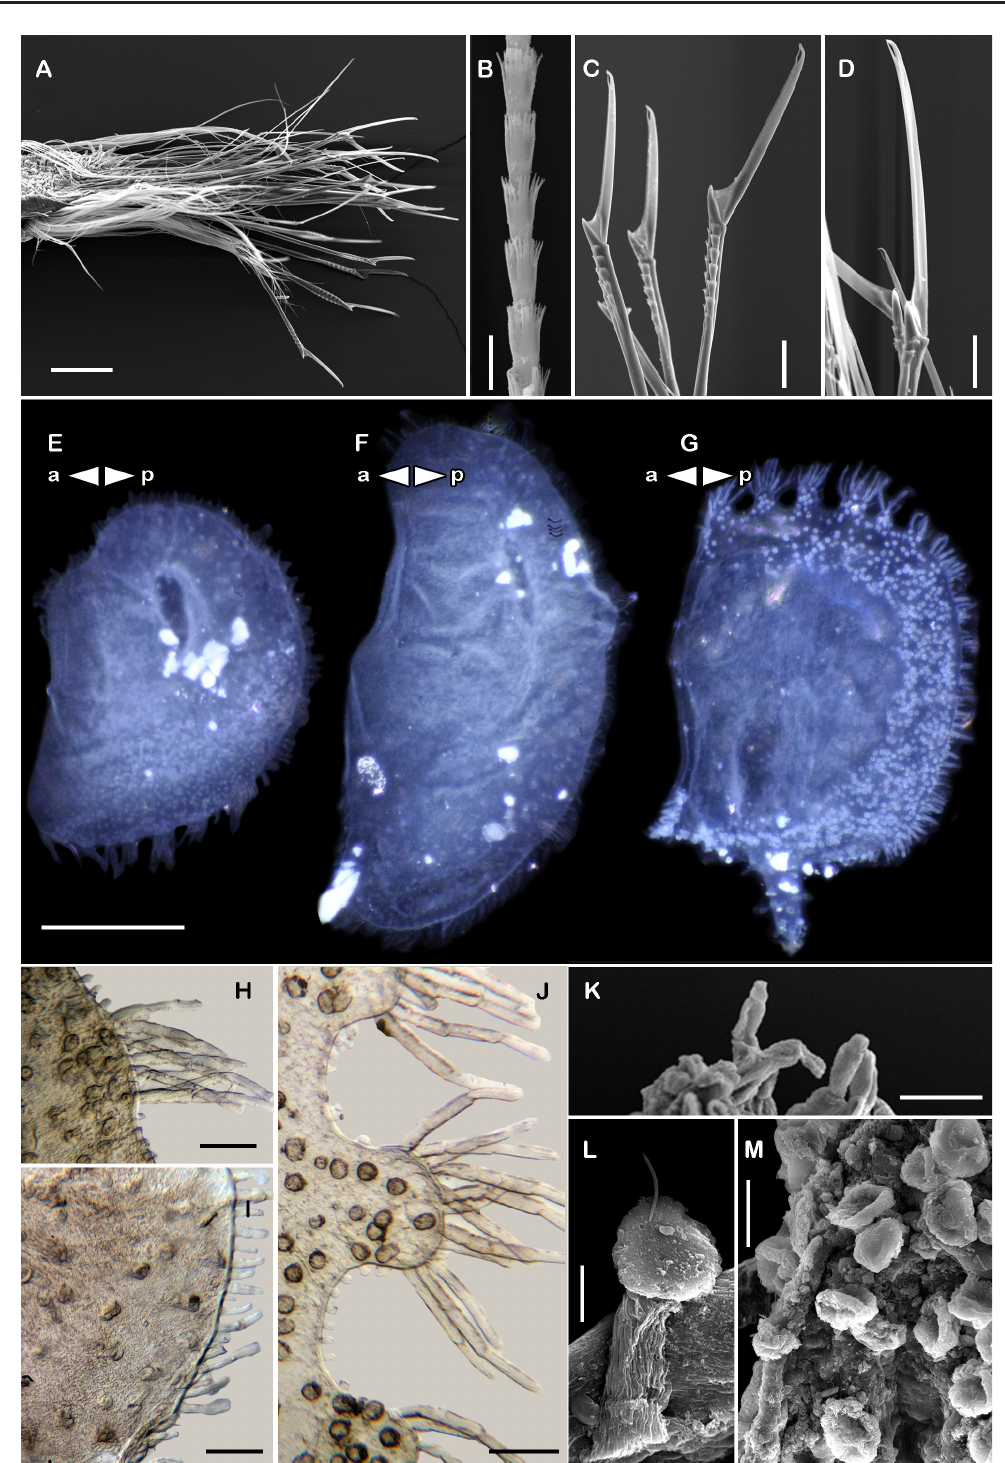
Fig. 6. Hartmanipsammolyce pettiboneae sp. nov., holotype (UMML 22.10887). A–D, K–M. SEM micrographs. A . Right parapodium from segment 30. B . Notochaeta from same. C . Units A and B. D . Unit D. E . First right elytron. F . Second right elytron. G . Posterior right elytron. H . Proximal margin of E. I . Posterior margin from E. J . Posterior processes from G. K . Segmented long papillae. L . Pedunculate papilla with flat tip. M . Surface of E. Abbreviations: a = anterior; p = posterior. Scale bars: A = 200 μm; B = 5 μm; C–D, H–K = 50 μm; E–G = 1 mm; L = 10 μm; M =